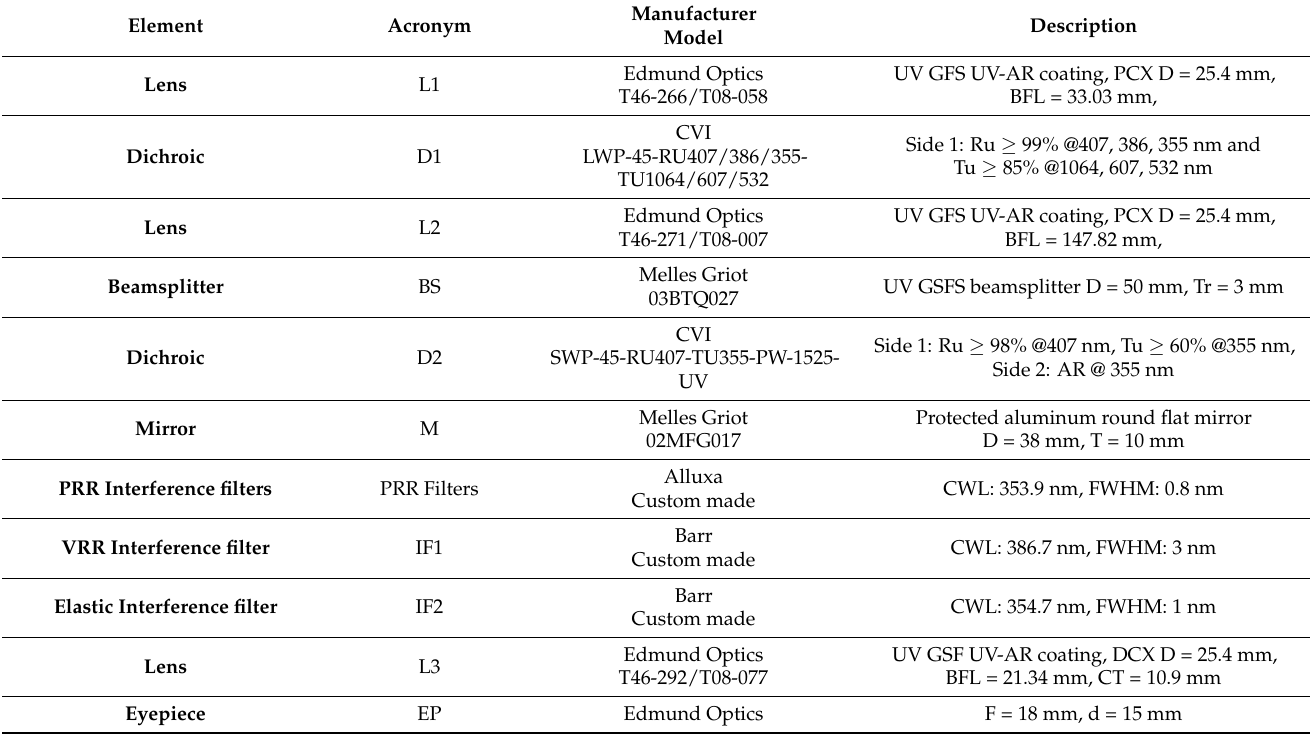
Table 2. Description of the optical elements.